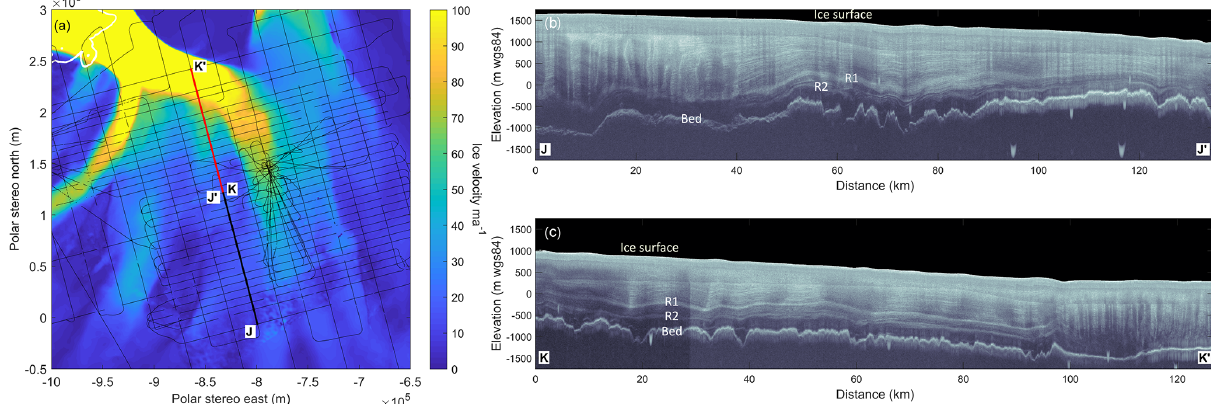
Figure 2. A total of 260km of radar data along tie line 9 demonstrating the typical stratigraphy of the ice column (high-reflectivity meteoric ice, underlain by low-reflectivity lower ice column with high-reflectivity layers) and the brightness and widespread nature of the band of ice layers (R1 and R2) throughout the IIS and MIS catchments: (a) map of ice velocity (Mouginot et al., 2019) with the IMAFI survey grid (thin black lines), grounding line (white line), and location of radar data in (b) (thick black line) and (c) (thick red line). The ice velocity colour scale is saturated at 100ma − 1 . (b) Radargram of the upper to middle IIS catchment (thick black line in a ). Note the bifurcation of R2 into 3–4 layers between 50–80km. (c) Continuation of the radargram shown in (b) into the middle to lower IIS catchment (thick red line in a ). Radargrams in (b) and (c) are radar survey tie line 9, which is also shown in Figs. 4 and S1. Isolated U-shaped “blobs” are artefacts associated with SAR processing of the radar